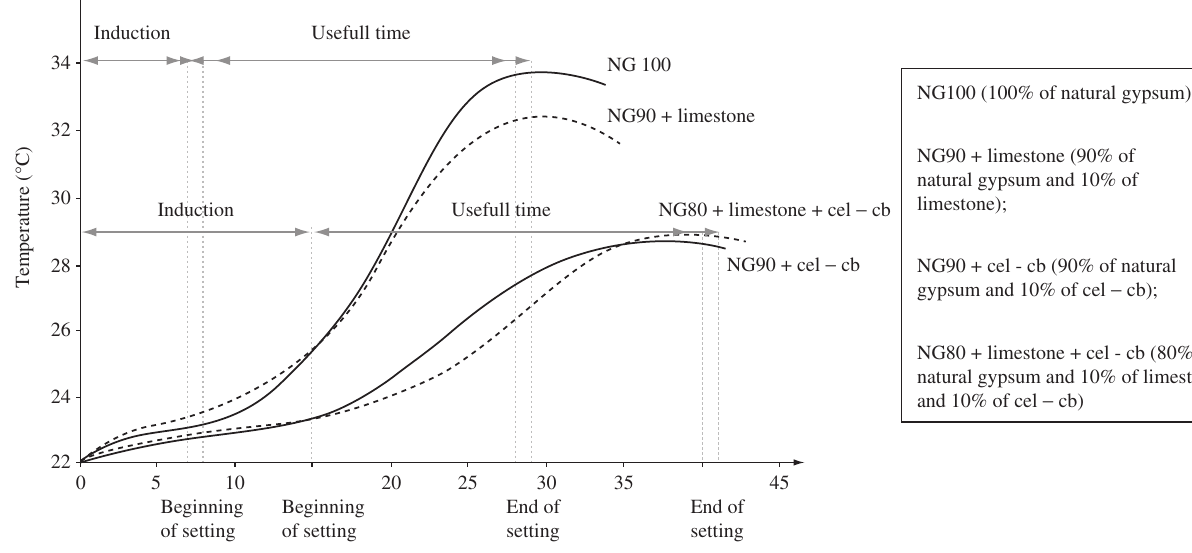
Figure 12. Hydration heat curves obtained with a pseudo-adiabatic